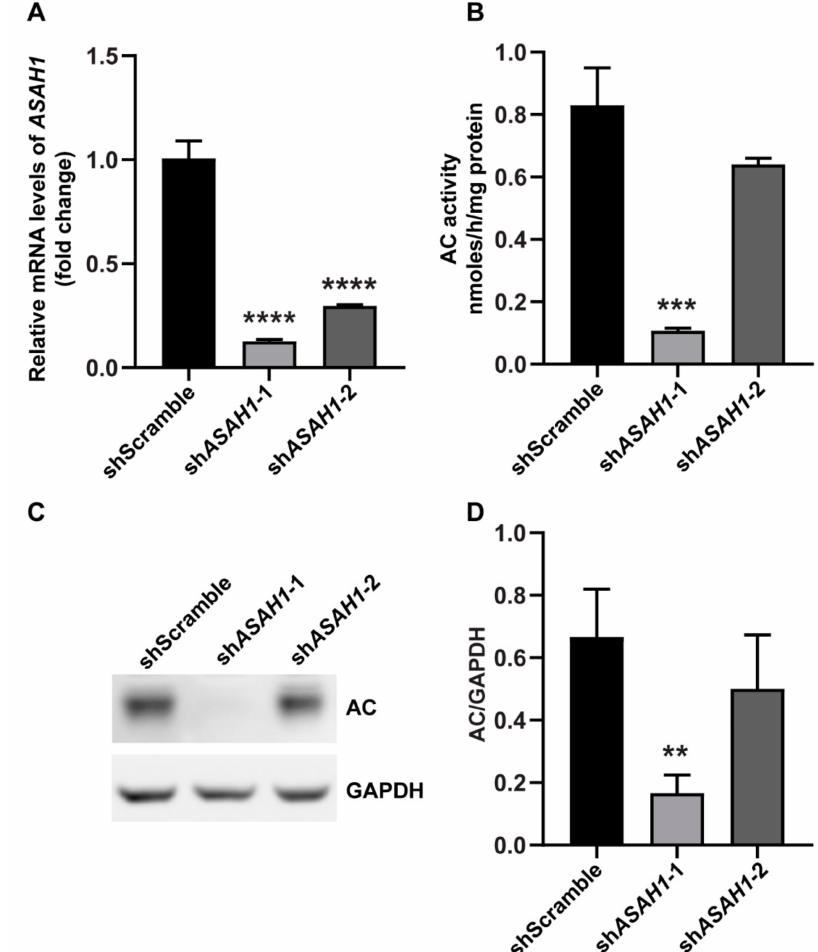
Figure 1. Knockdown of ASAH1 by lentiviral shRNA transduction in SH-SY5Y cells. ( A ) Relative mRNA expression levels of ASAH1 stably expressing either sh ASAH1 -1 or sh ASAH1 -2, compared to cells stably expressing a scrambled shRNA (shScramble), after normalization for endogenous GAPDH expression. Data are represented as the mean ± SEM of three independent triplicate experiments (one-way ANOVA analysis). ( B ) Enzyme activity of AC in sh ASAH1 -1 and sh ASAH1 -2 cells compared to shScramble cells. The activity was measured using an artificial fluorogenic substrate and was expressed as nmoles of product / h / mg protein. Data are expressed as the mean ± SEM of three independent triplicate experiments (one-way ANOVA analysis). ( C ) Representative immunoblot of AC in sh ASAH1 -1, sh ASAH1 -2 and shScramble cells. GAPDH was used as loading control. ( D ) Quantification of density of AC bands normalized by density of GAPDH bands for each sample detected by Western blot. Data are expressed as the mean ± SD of three independent experiments (one-way ANOVA analysis). ** p < 0.01, *** p < 0.001 and **** p < 0.0001 compared to